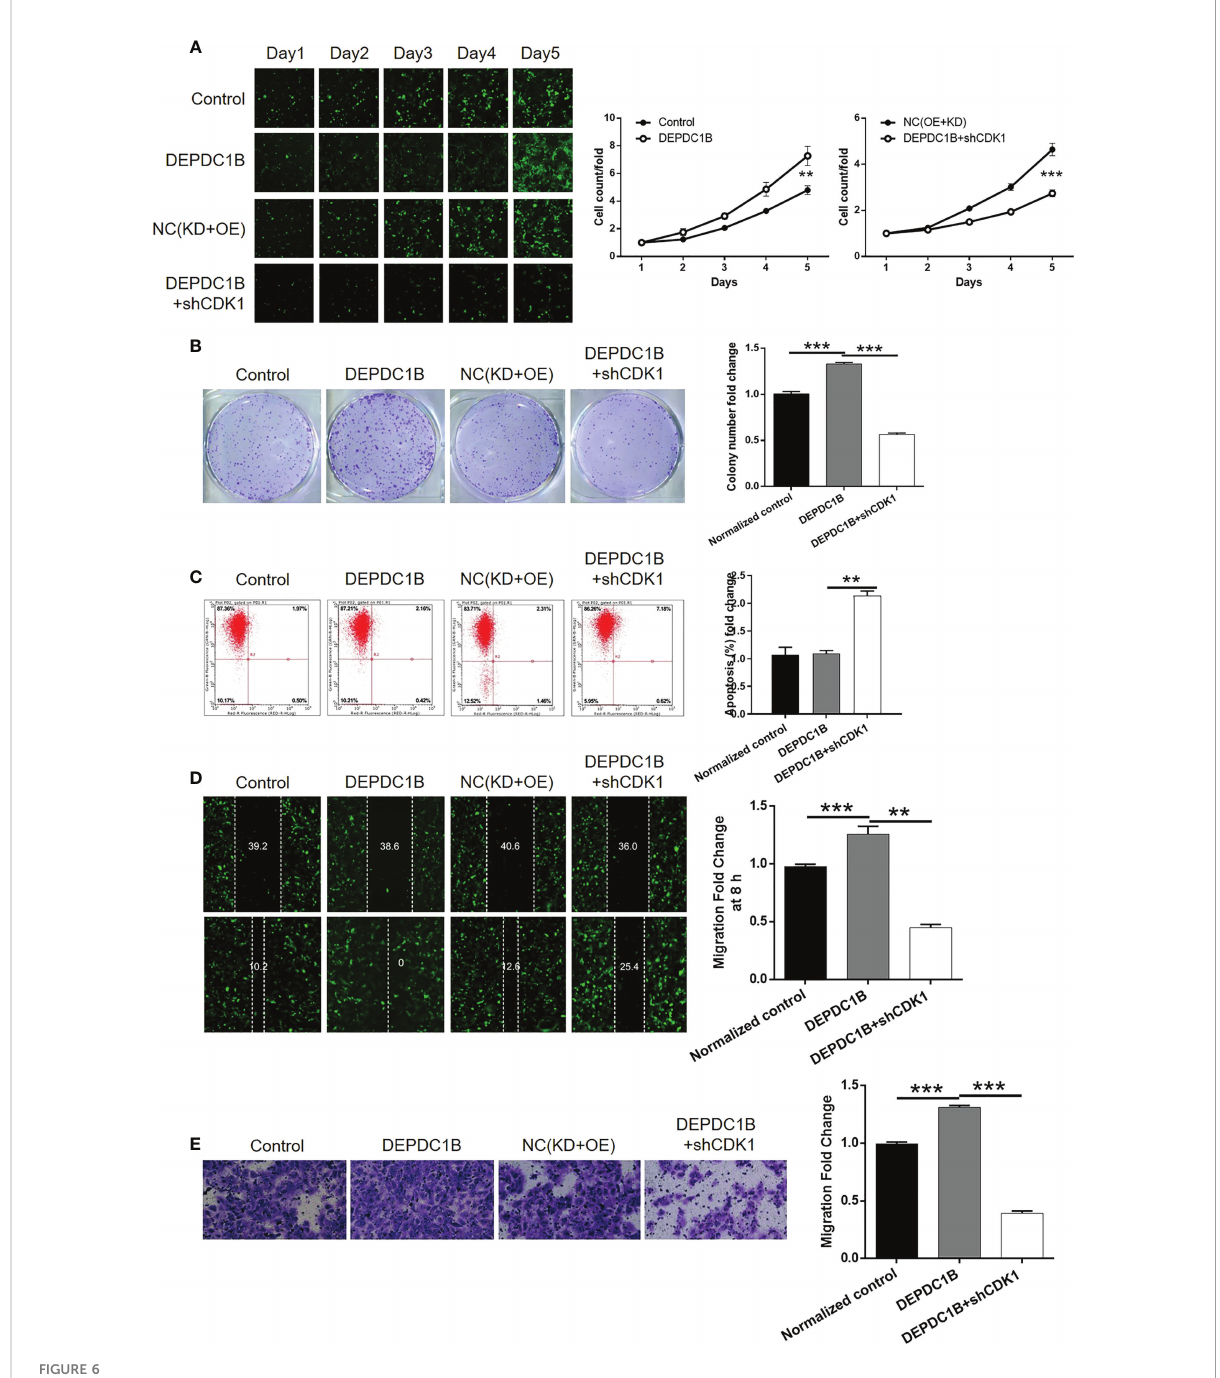
FIGURE 6 Knockdown of CDK1 attenuated the effects of CCA cells by DEPDC1B overexpression. HUCCT1 cells transfected with control plasmids, DEPDC1B overexpression plasmids, NC(OE+KD), and simultaneous DEPDC1B overexpression plasmids, and shCDK1 were subjected to the detection of cell proliferation by Celigo cell counting assay (A) , colony formation (B) , cell apoptosis by fl ow cytometry (C) , cell migration by wound healing assay (D) , and cell migration by Transwell assay (E) . The representative images were selected from at least three independent experiments. Data were shown as mean ± SD (n = 3). ** P < 0.01, *** P <